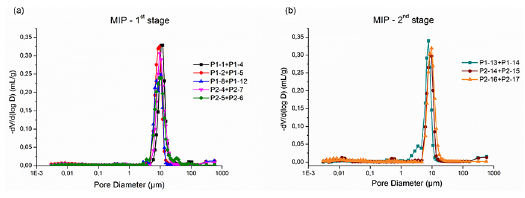
Figure 13. MIP analyzes: (a) 1 st stage; (b) 2 nd